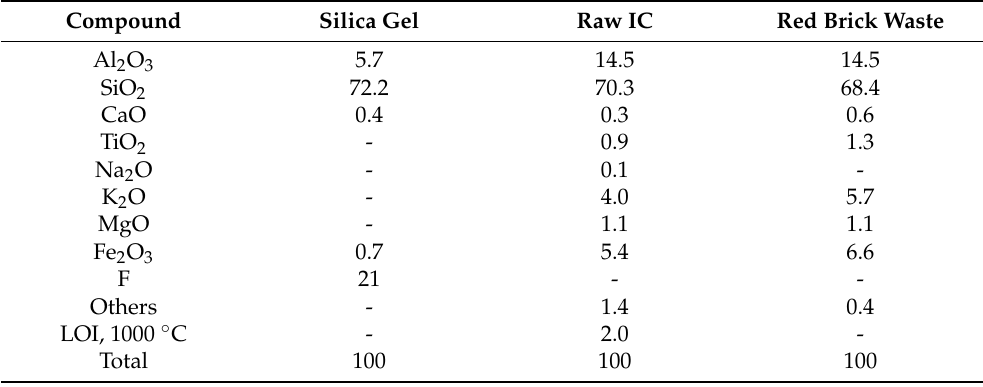
Table 1. Elemental composition of silica gel, raw IC, and red brick waste from Lode detected by XRF, mass, %. Compound Silica Gel Raw IC Red Brick Waste Al 2 O 3